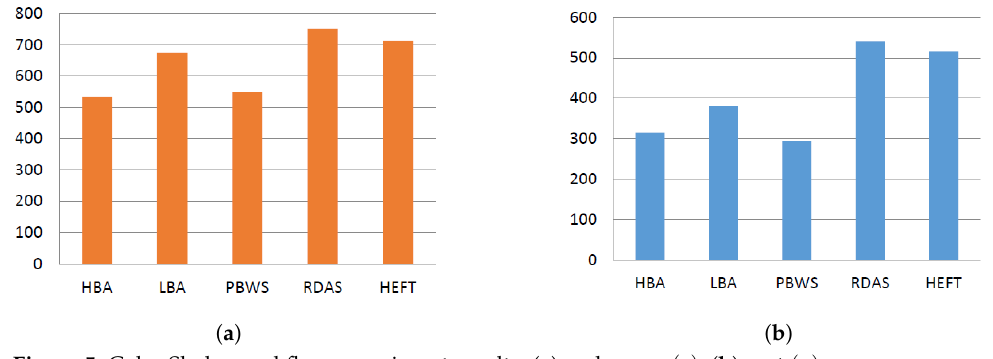
Figure 5. CyberShake workflow experiment results. ( a ) makespan ( s ) ; ( b ) cost (  )